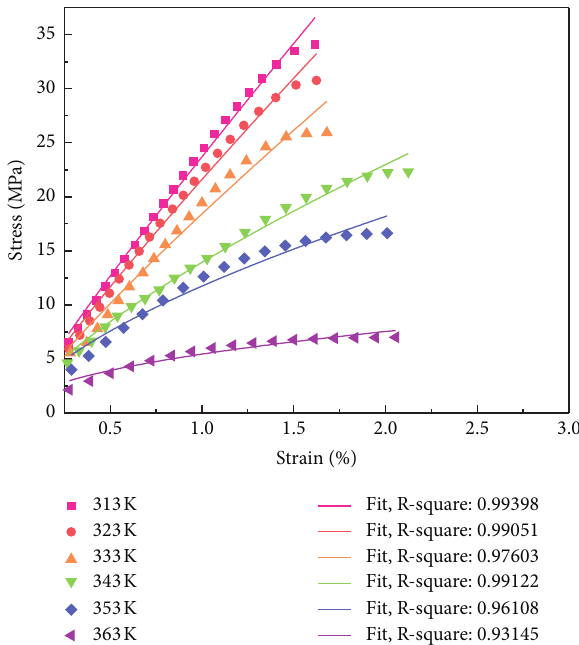
Figure 3: Fitting curve at different temperatures in the range of 0.25% to yield strain.